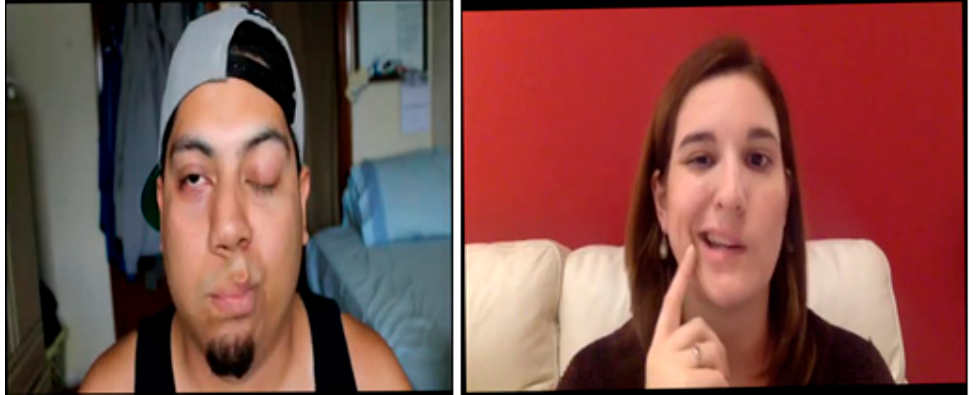
Figure 2. Examples of face palsy images.